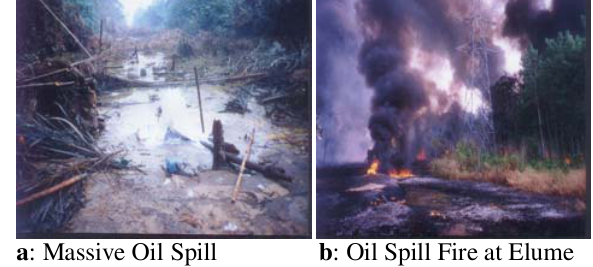
Figure 2: Classified image of Landsat TM, May 11,